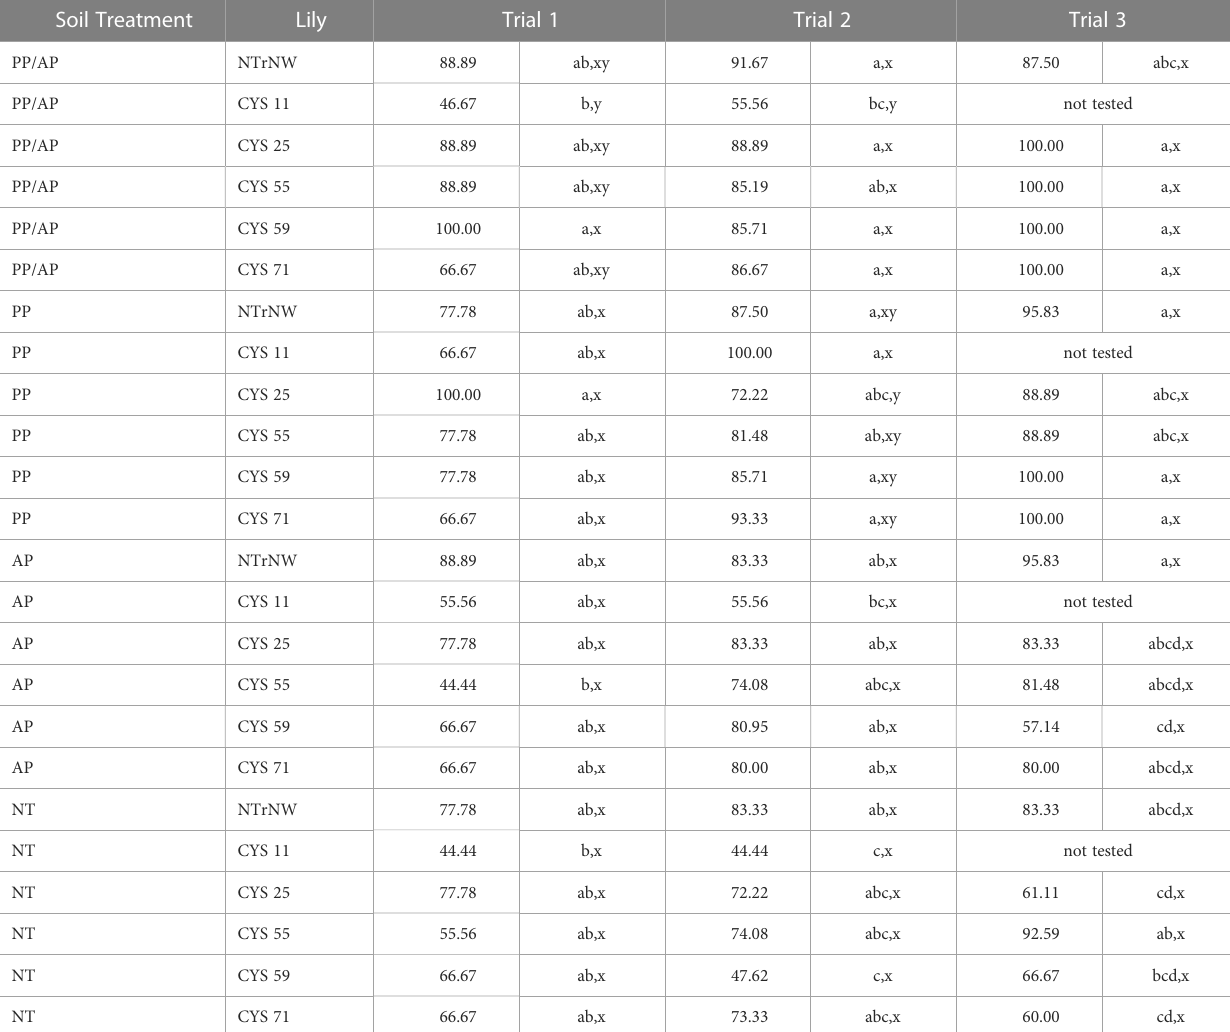
TABLE 6 Percent survival of Easter lily plants at harvest in fi eld trials conducted at the Easter Lily Research Foundation Research Station in Brookings, OR, USA in soil naturally infested with lesion nematode ( Pratylenchus penetrans ). Soil Treatment